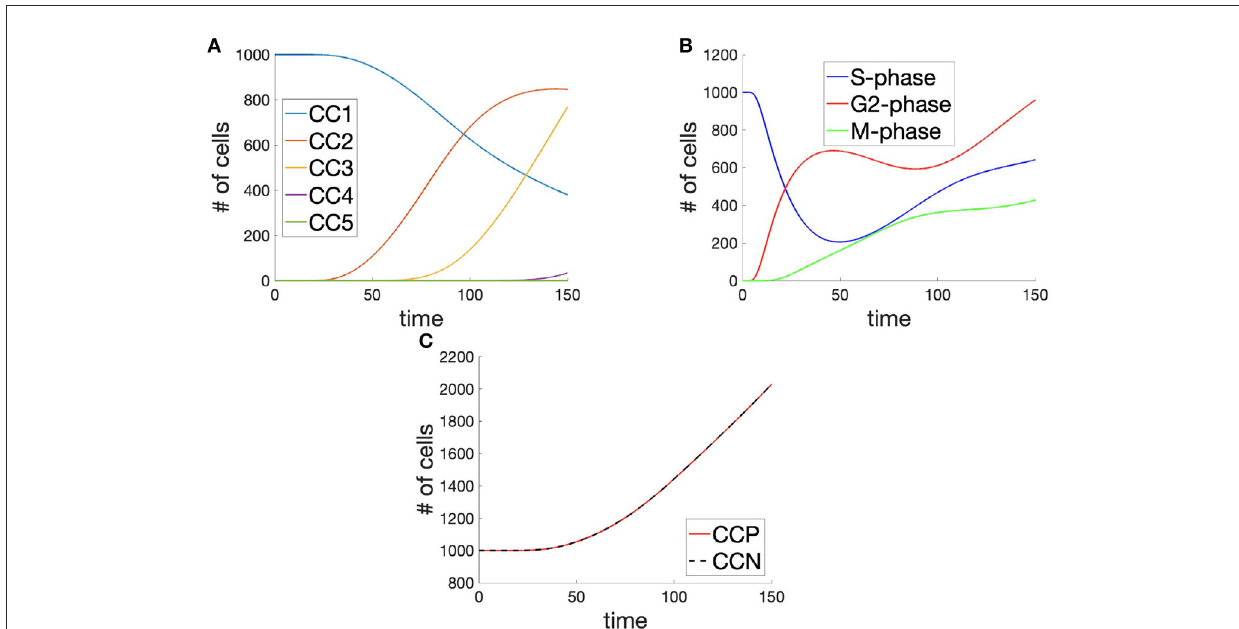
FIGURE5 Cell populations (A) in each cell cycle, (B) in each of the phases (across cell cycles), and (C) the total cell population shown as the integral across cell cycle phases (CCP) and cell cycle number (CCN), in time, demonstrating mass-balance between